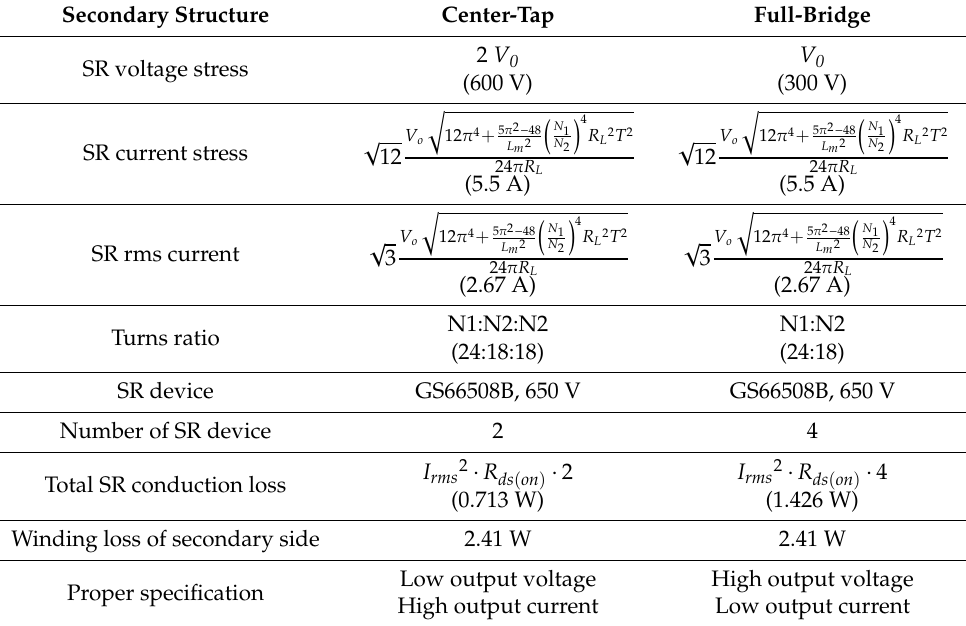
Figure 3. Secondary-side architecture: ( a ) center tap and ( b ) full bridge. Table 2. Comparison of secondary-side architectures.